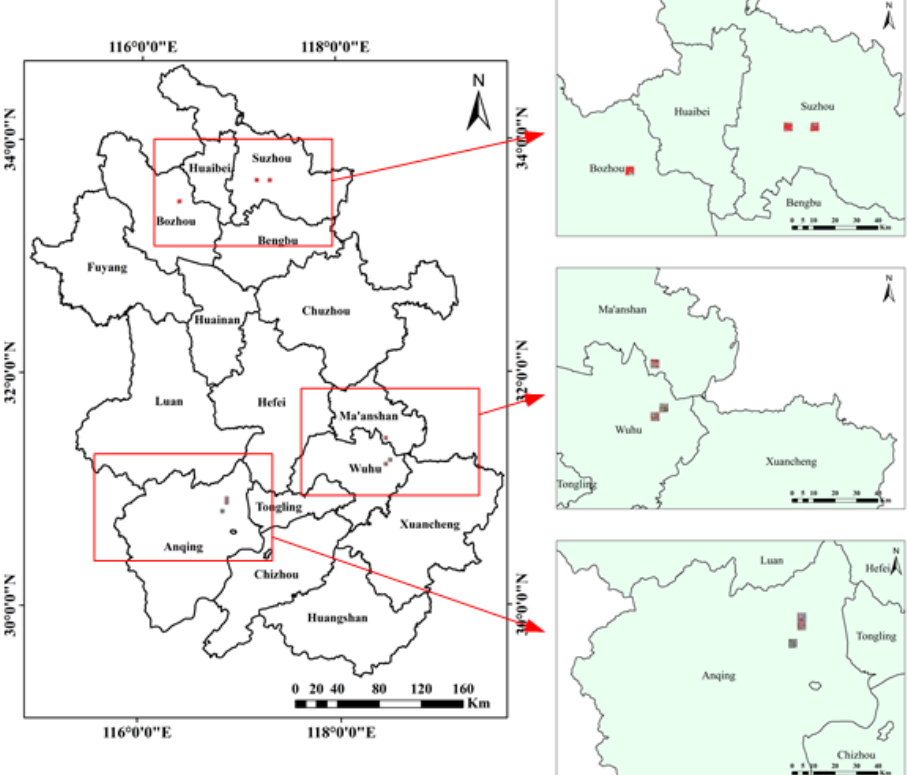
Figure 11. Specific distribution status of the test area (the red boxes are the test areas in the northern, central and southern parts of the study area selected for this